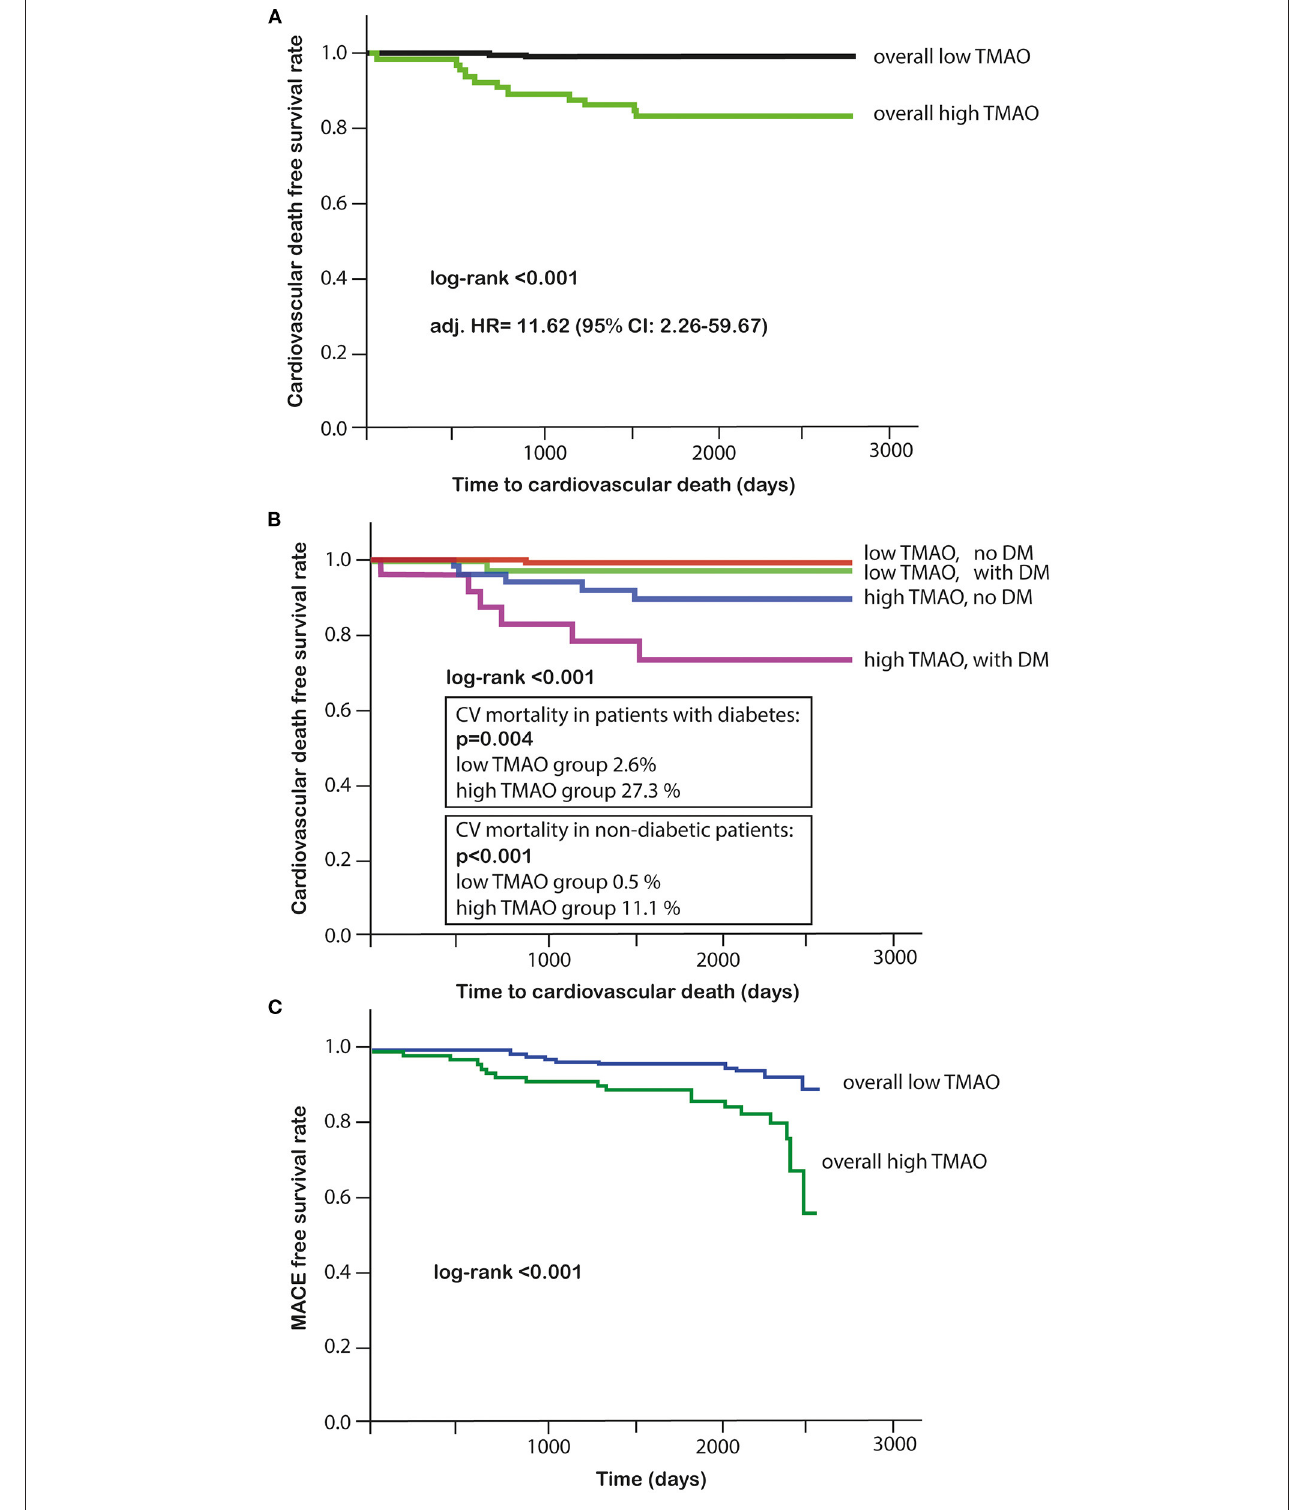
FIGURE 4 | (A) Kaplan-Meier survival analysis for cardiovascular death in high or low TMAO subgroups; (B) Kaplan-Meier survival analysis in DM and high or low TMAO subgroups; (C) Kaplan-Meier survival analysis for MACE in high or low TMAO subgroups.